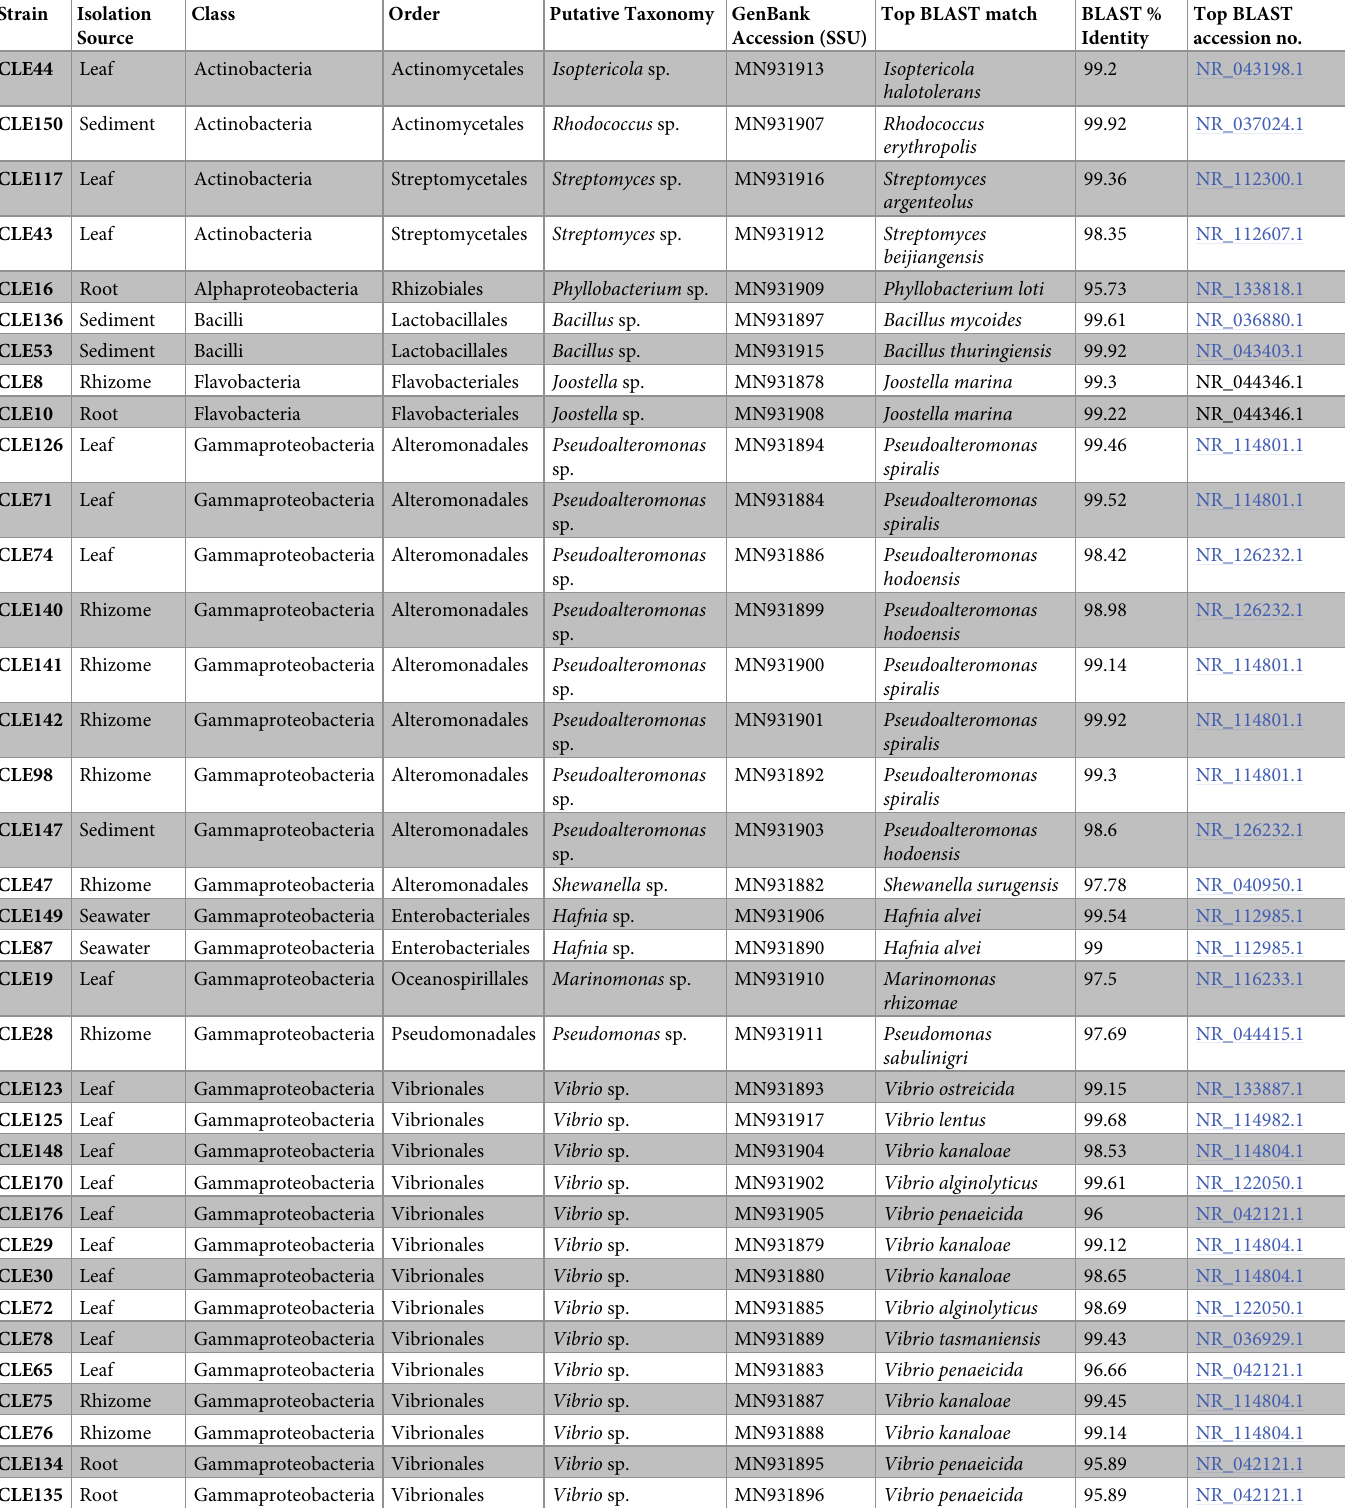
Table 2. Bacteria isolated from the seagrass, Zostera marina